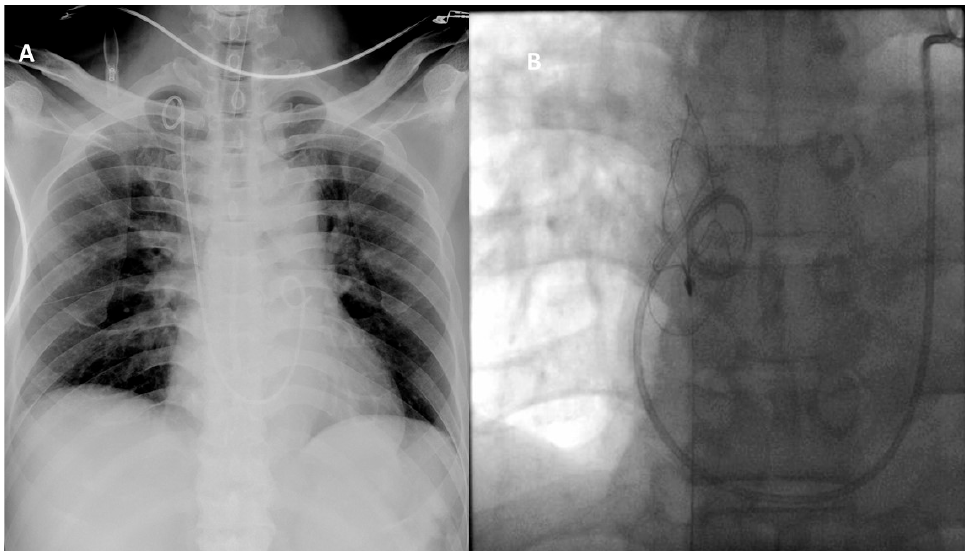
Figure 2. ( A ) The ureteral double-J stent was misplaced into the branch of the renal vein and forward migrated into the inferior vena cava, right atrium, right ventricle, and distal-J end in the pulmonary artery. ( B ) Double-J stent grasped by angiographic snare loop wire via right femoral vein entry ac- cess.